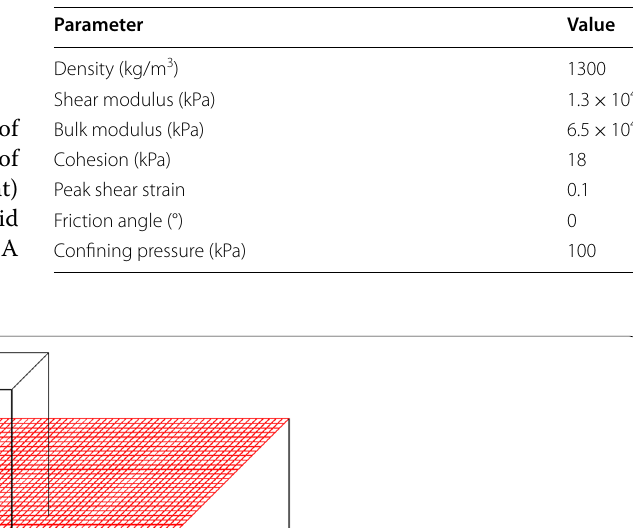
Table 1 Empirical parameter values of the soft soil site